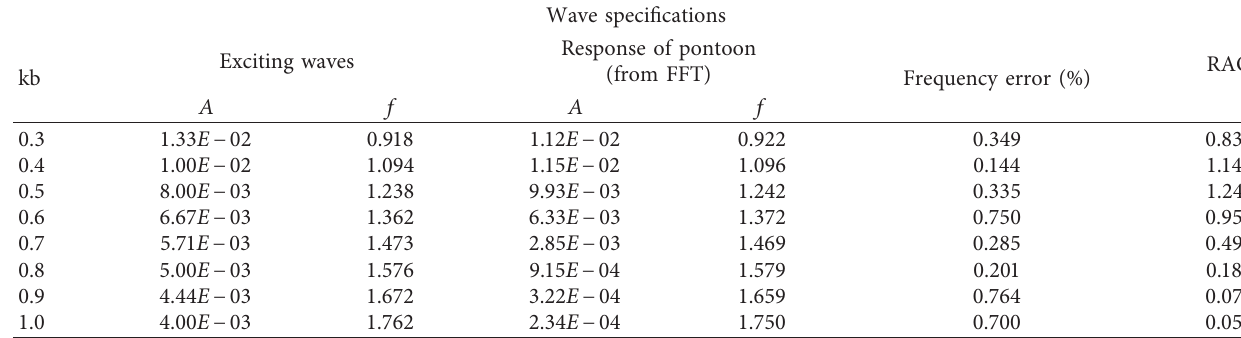
Table 11: Amplitude and frequency of the heaving pontoon for breakwater number 3.